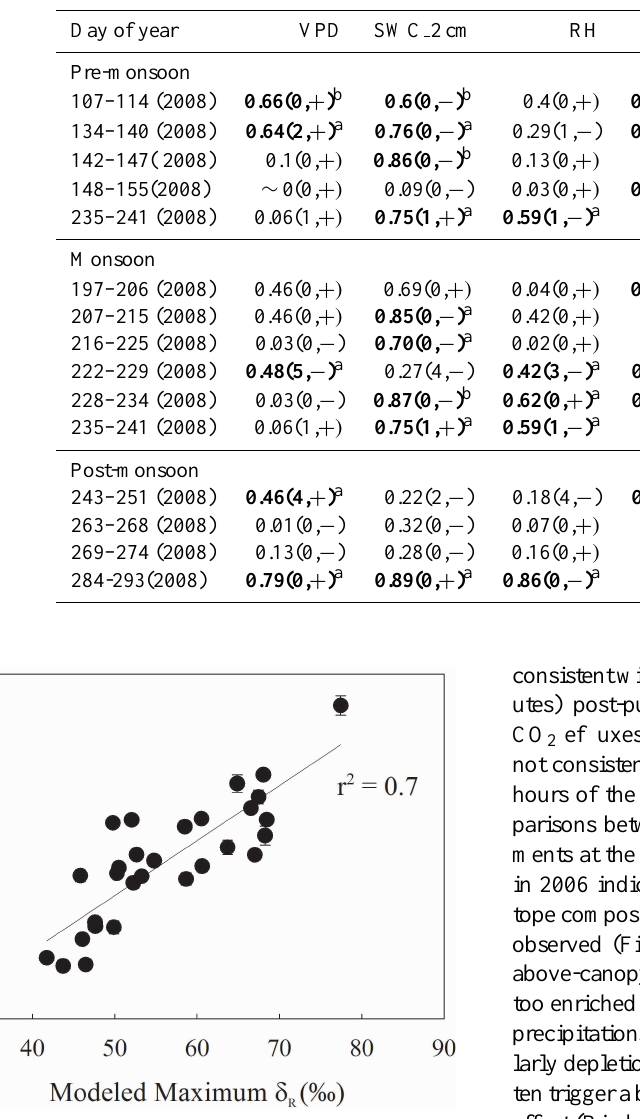
Fig. 6. Comparison between measured and modeled maximum δ R changes within 7 days of